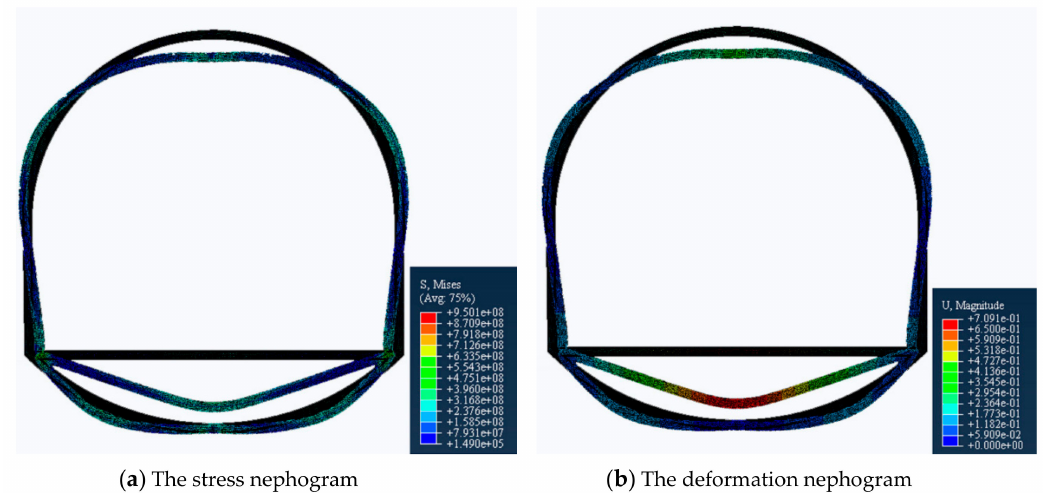
Figure 17. The stress nephogram and the deformation nephogram of FB set